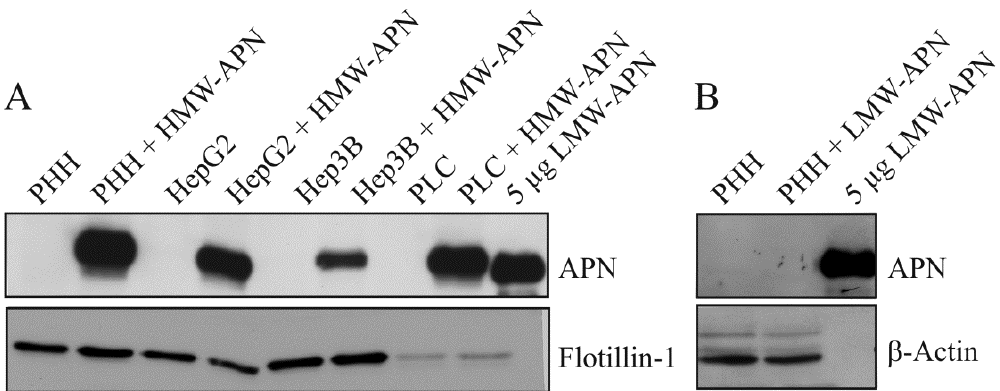
Figure 1. Adiponectin ( APN) in hepatocyte lysates. ( A ) Primary human hepatocytes (PHH), HepG2, Hep3B and PLC/PRF/5 hepatoma cell lines were cultivated in the presence of 10 µg/mL of high molecular weight (HMW)-APN for 24 h. APN and Flotillin-1 were analyzed by immunoblot, and APN was detected in lysates of HMW-APN-incubated PHH. Recombinant low molecular weight (LMW)-APN is shown as the positive control; ( B ) PHH were cultivated in the presence of 2 µg/mL of LMW-APN for 24 h. APN and β -actin were analyzed by immunoblot. APN is not detected in cell lysates.